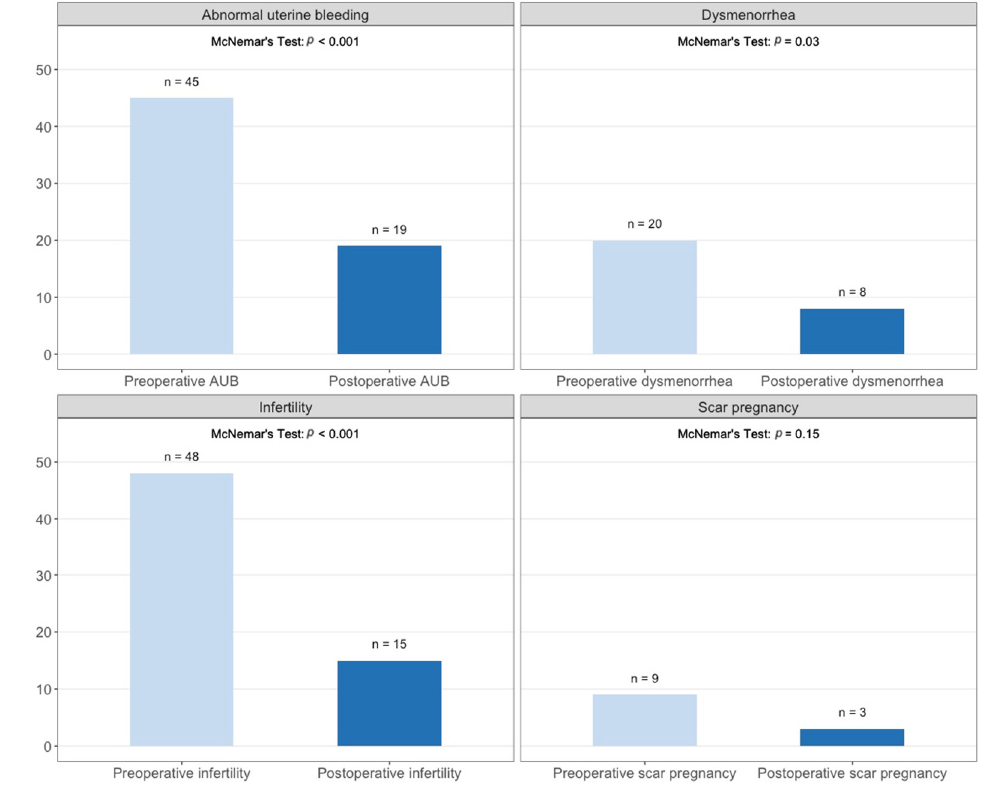
Figure 1. Comparison of symptoms in the study population before and after operation. Significant differences were detected in patients with abnormal uterine bleeding ( p < 0.001, missing values = 3), dysmenorrhea ( p = 0.03, missing values = 3), and infertility ( p < 0.001; missing values = 5). After the operation, five patients developed bleeding disorders and five patients developed dysmenorrhea.